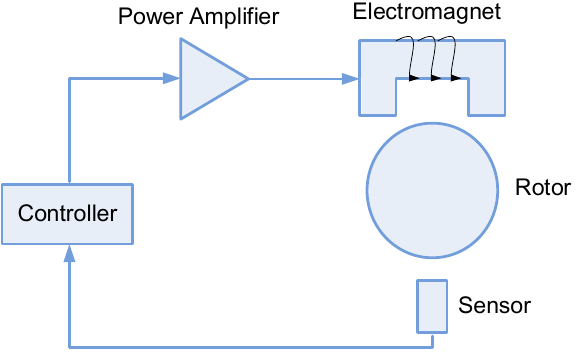
Figure 2. The basic model of